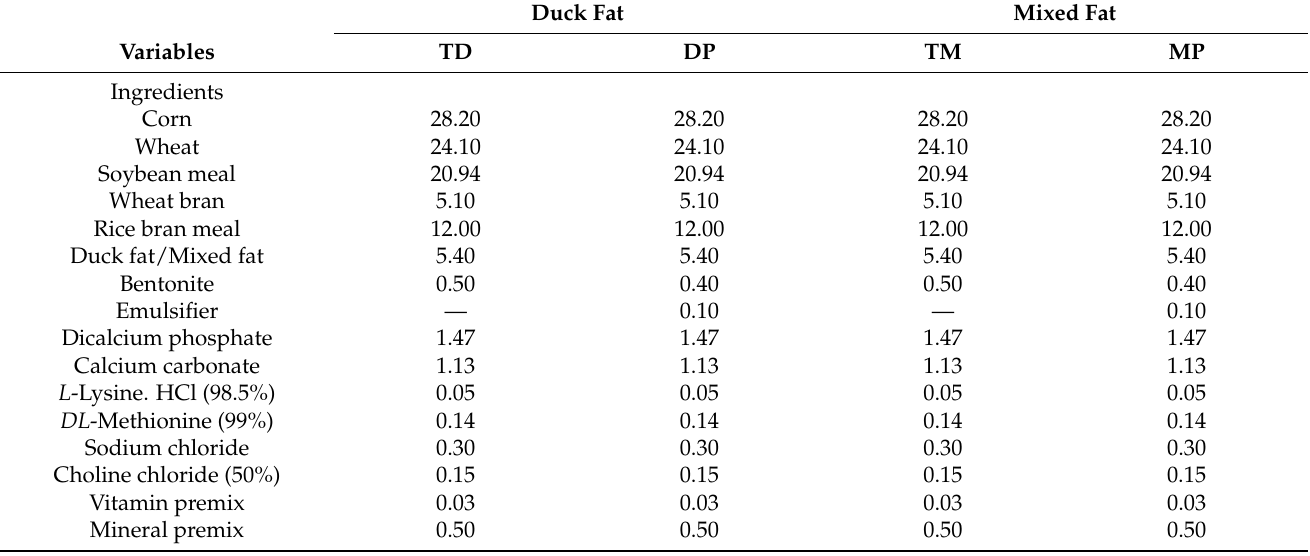
Table 1. Composition and nutrient contents of the experimental diets (%, air dry basis) 1–3